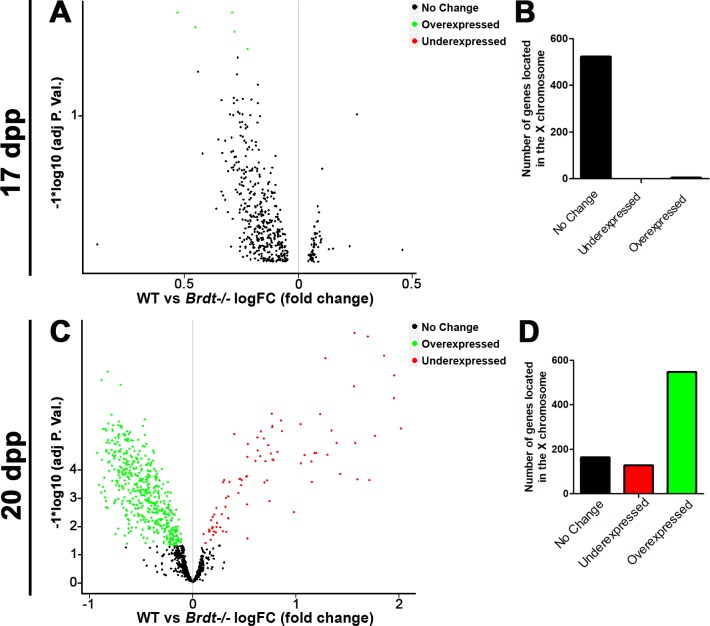
BRDT contributes to the transcriptional silencing of the X chromosome in spermatocytes.(A, B) Volcano plot representation of differentially expressed X-linked genes in Brdt-/- 17dpp (A) and 20dpp testes (B). The X axis represents the log fold-change (FC) in WT vs Brdt-/- spermatogenic cells. The Y axis represents the adjusted p-value. Only genes with an adjusted p-value of ≤0.05 were considered as differentially expressed genes (DEGs). (B, D) Number of X-linked genes with no change in expression, under-regulation or up-regulation in Brdt-/- 17dpp (B) and 20dpp (D) testes as compared to WT testes.